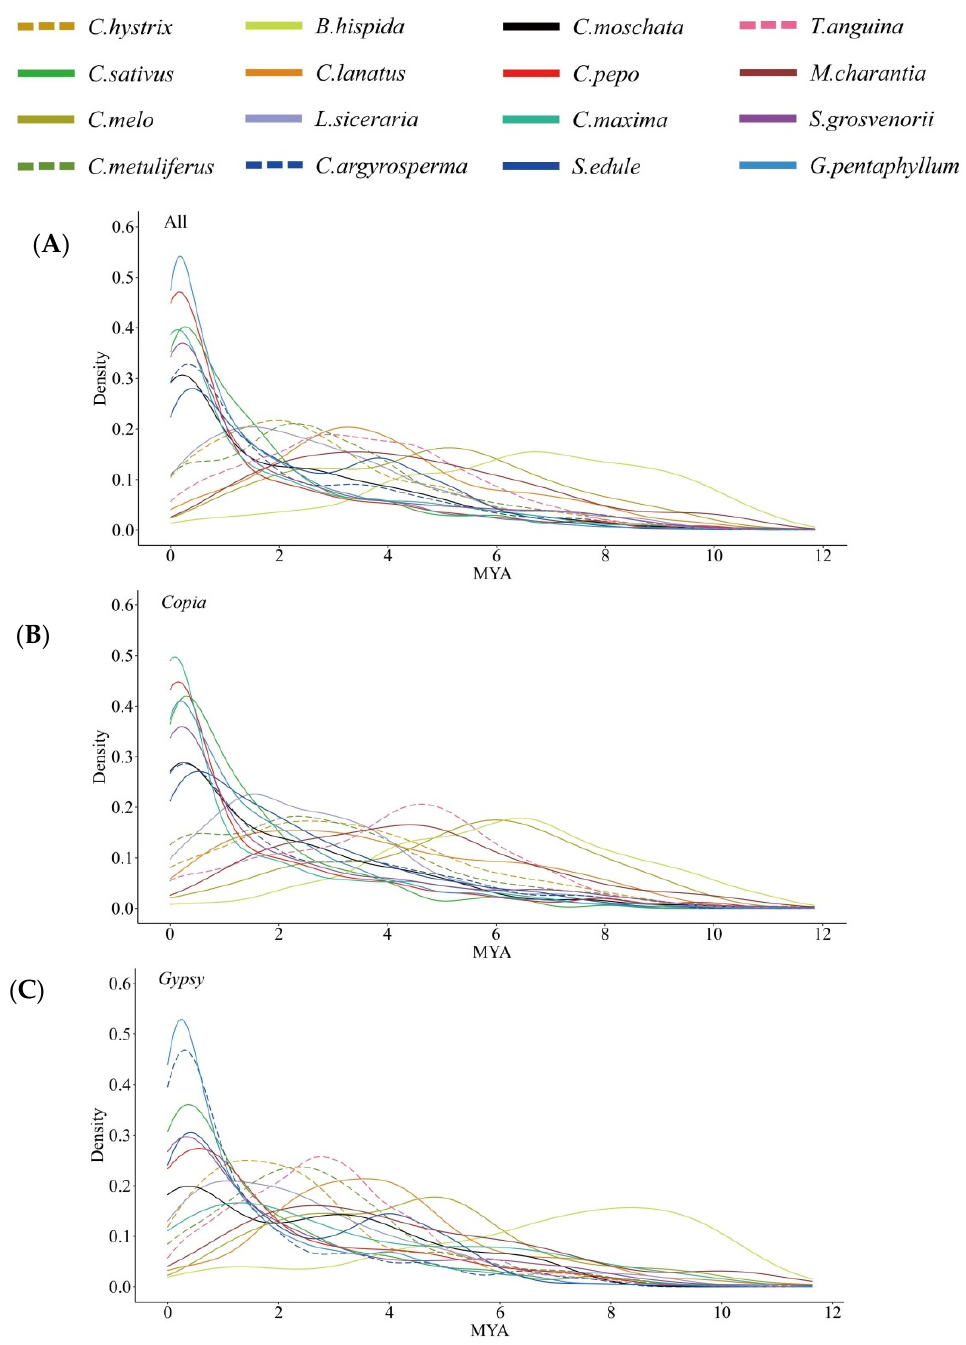
Figure 4. Distribution of full-length LTR-RTs in each species according to their estimated insertion ages (MY). ( A ) All full-length LTR-RTs; ( B ) Copia elements; ( C ) Gypsy elements. These full-length LTR-RTs were further classified as different lineages according to their RT protein domains to investigate the LTR-RTs in detail. The Copia and Gypsy elements were subclassified into seven and six lineages, respectively (Figure 5A). In general, among